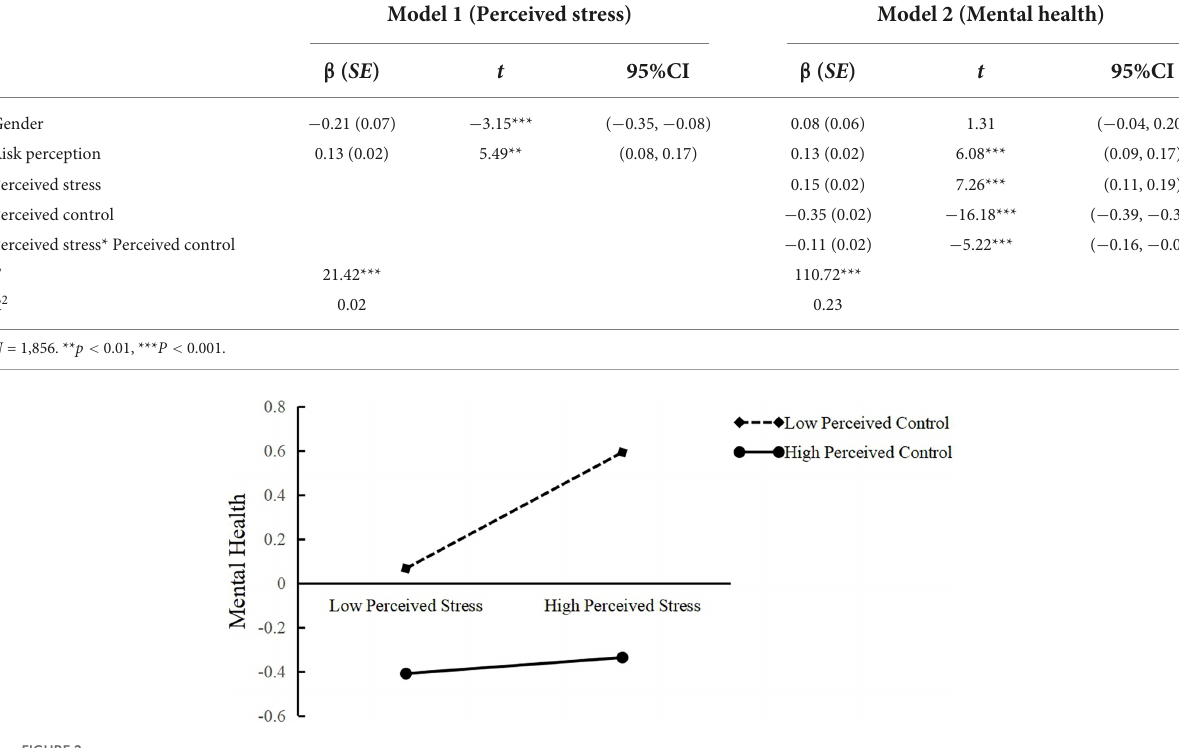
FIGURE2 Perceived control moderates the relationship between perceived stress and mental